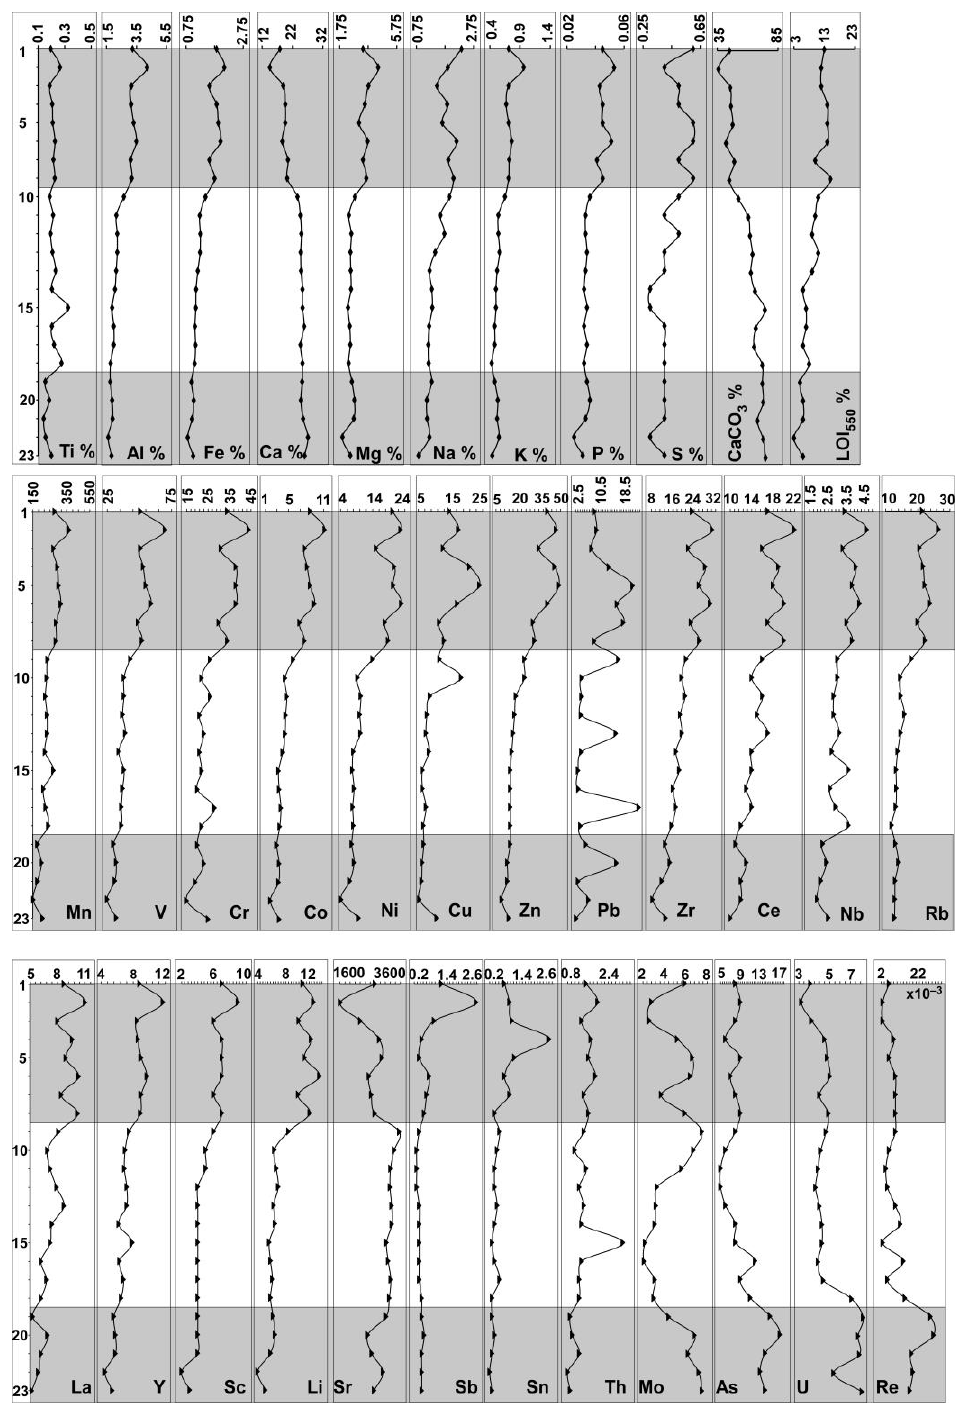
Figure 3. The upcore variation in the concentrations of major (%) and trace elements (µg/g). Elements Al, Fe, Mg, K, Na, OM, Mn, V, Cr, Co, Ni, Zn, Zr, Ce, Nb, Rb La, Y, Li, and Sc display the same profile enriched in the upper unit, Ca, CaCO3, and Sr behave similarly and Mo, As, U, and Re show similar vertical distribution pattern.